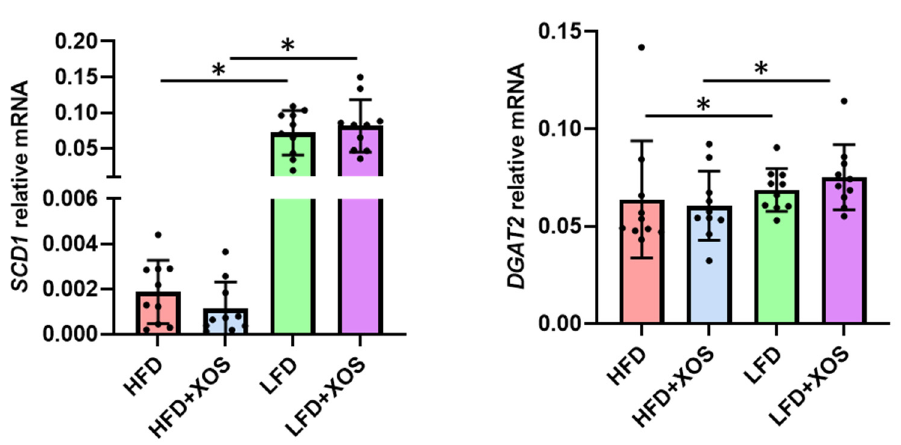
Figure 4. XOS did not affect the hepatic mRNA expression of stearoyl coenzyme desaturase 1 (SCD1) or Diacylglycerol O-acyltransferase 2 (DGAT2). n = 8–10/diet group. The different data points are shown with black dots. * indicates statistically significant difference between the groups.